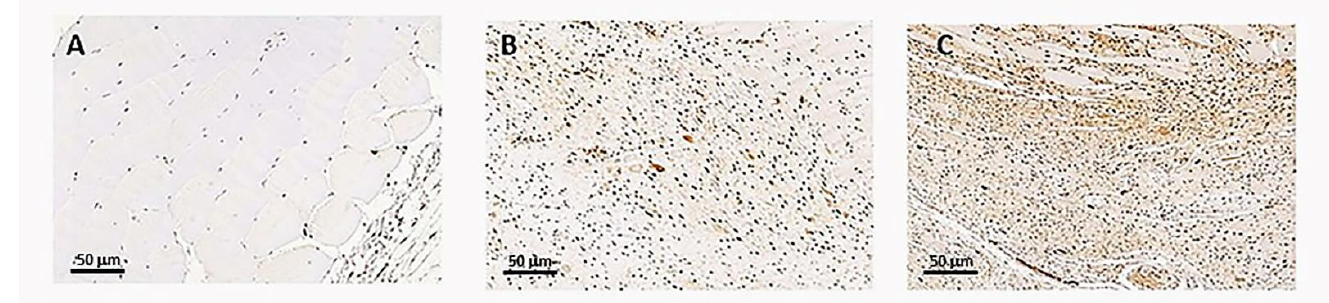
Figure 7. Representative Immunohistochemical positive p-Smad2/3 cells in stained slides of rabbits’ muscle tissue Image 20×. ( A ) Normal Tissue example, ( B ) P144 group example, ( C ). Placebo group.